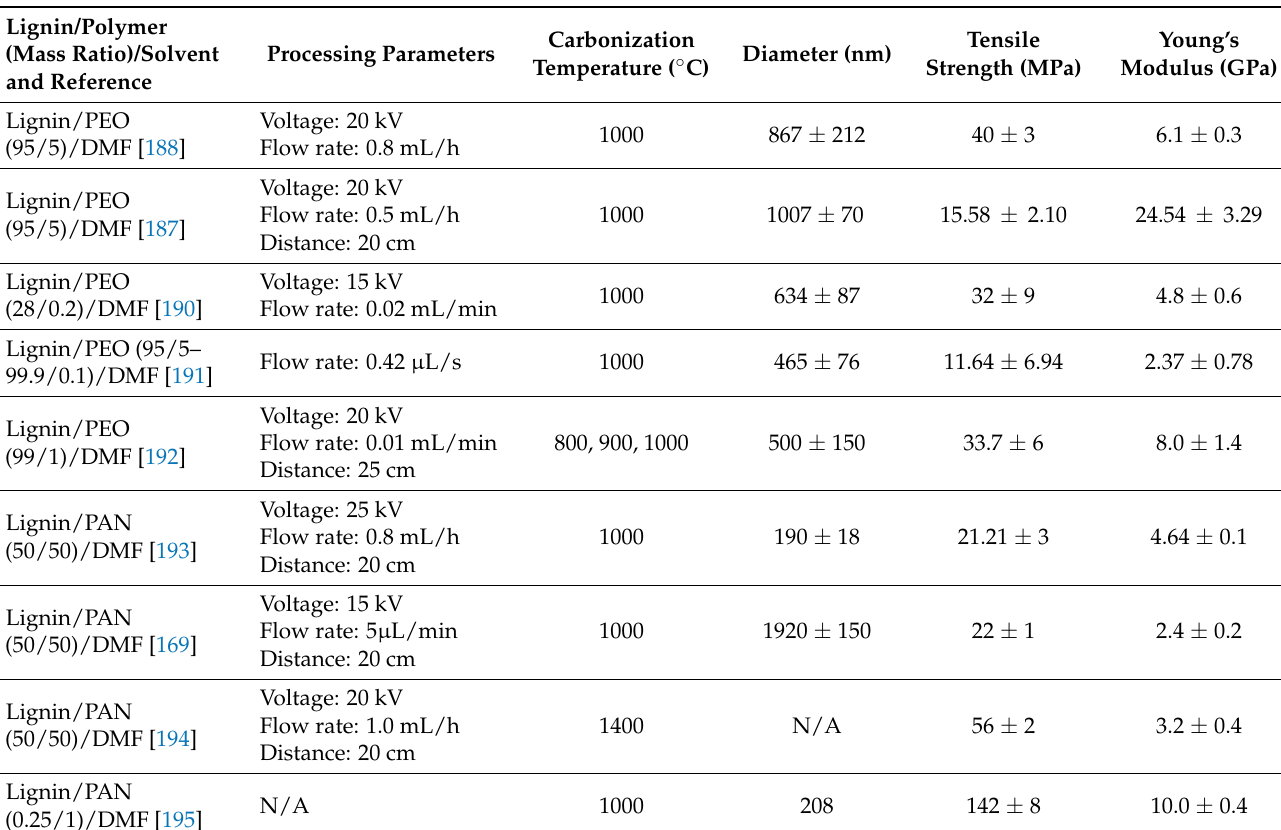
Table 3. Performance of electrospun CNFs from unmodified lignin/polymer blends.